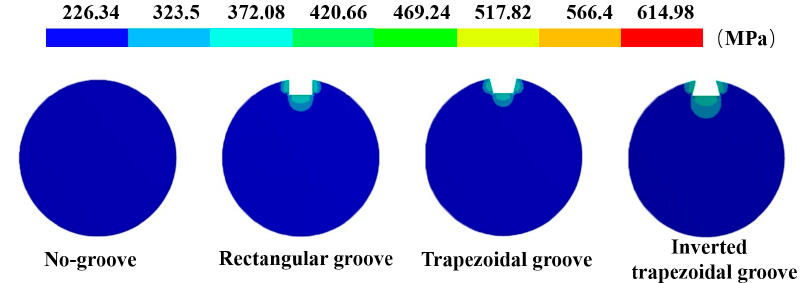
Figure 4. Stress distribution of different grooves.